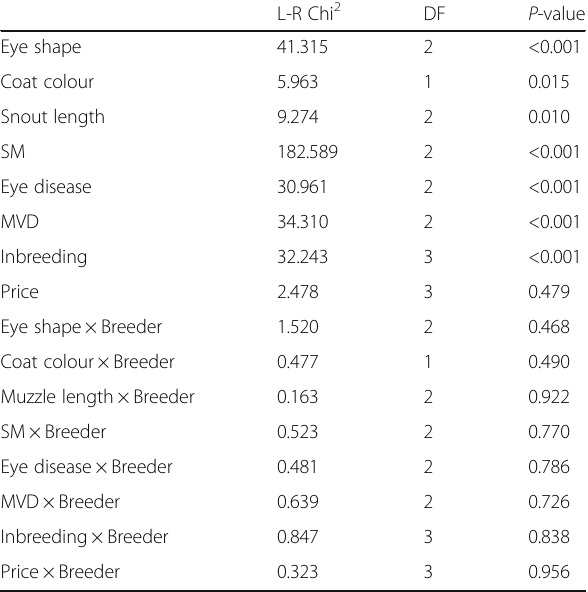
Table 2 Multinomial logit model results for each trait, including the interaction with breeder